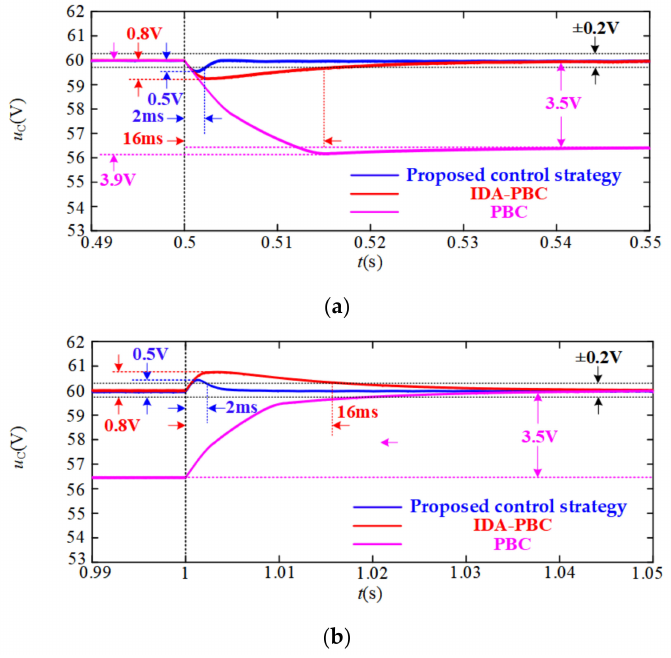
Figure 13. The simulation results of the different control strategies under CPL steps. ( a ) 60 W to 90 W at 0.5 s; ( b ) 90 W to 60 W at 1 s.